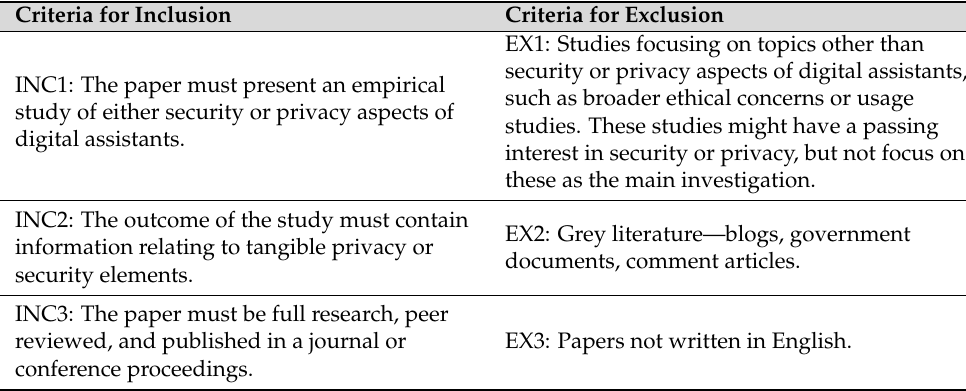
Table 2. Inclusion and exclusion criteria for study